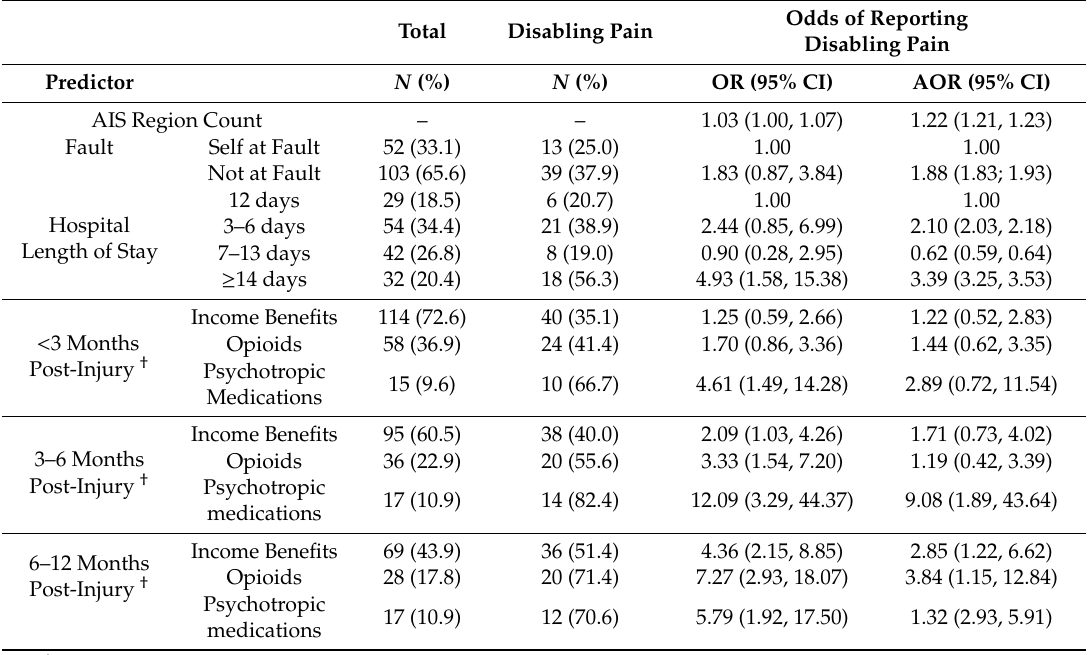
Table 4. Binary Logistic Multivariable Regression Coe ffi cients of Early Prognostic Factors for Chronic and Disabling Pain 12 Months after Compensable